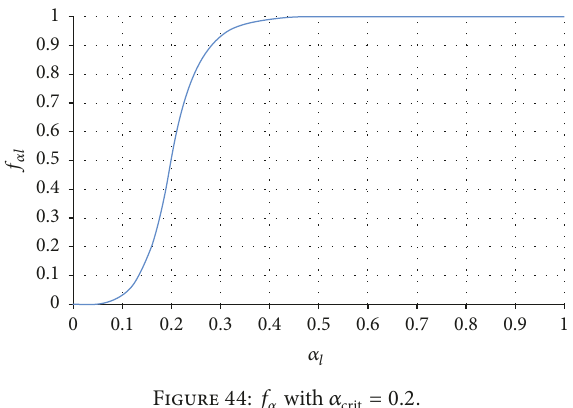
Figure 44: 𝑓 𝛼 with 𝛼 crit = 0.2 .